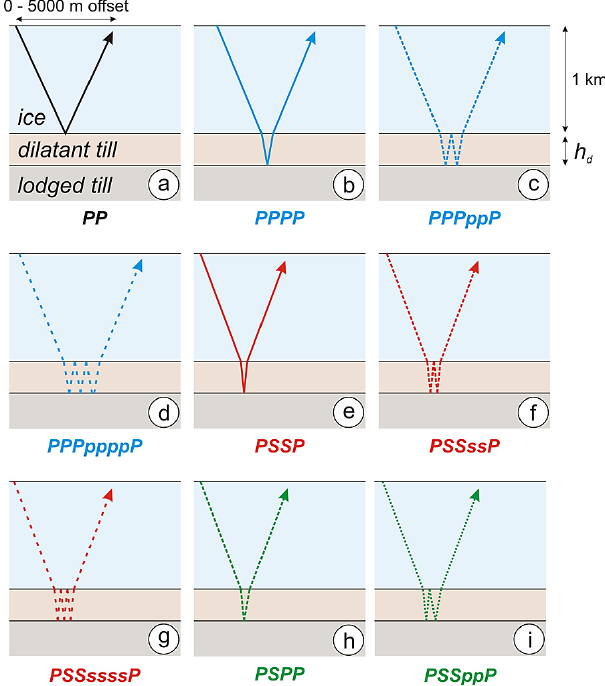
Fig. 2. Nomenclature and schematic representation of ray paths con- sidered in modelling. Line colours and styles are equivalent to those in successive figures. Ray path (a) is the basal ice reflection (black), (b–d) comprise P-wave propagation along the whole travel-path (blue), (e–g) have S-wave mode conversions within the dilatant till (red), and (h) and (i) convert between S- and P-wave modes within the dilatant till